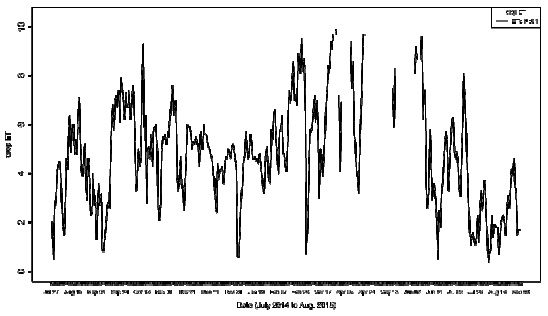
Figure 8. Citrus crop ET estimates for plot